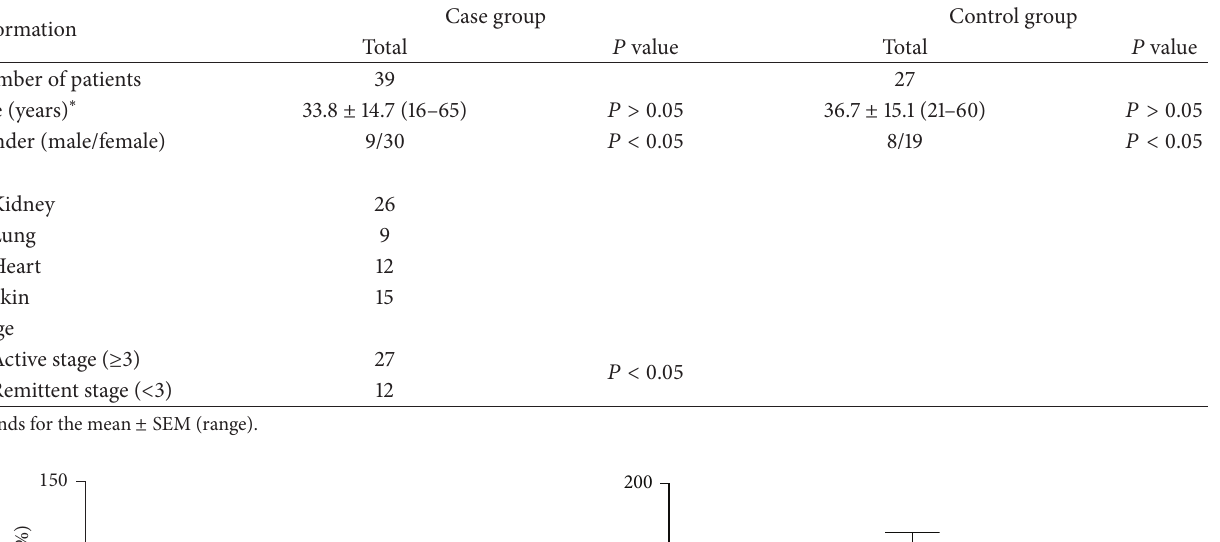
Table 1: Clinical characteristics for the patients enrolled in this study.